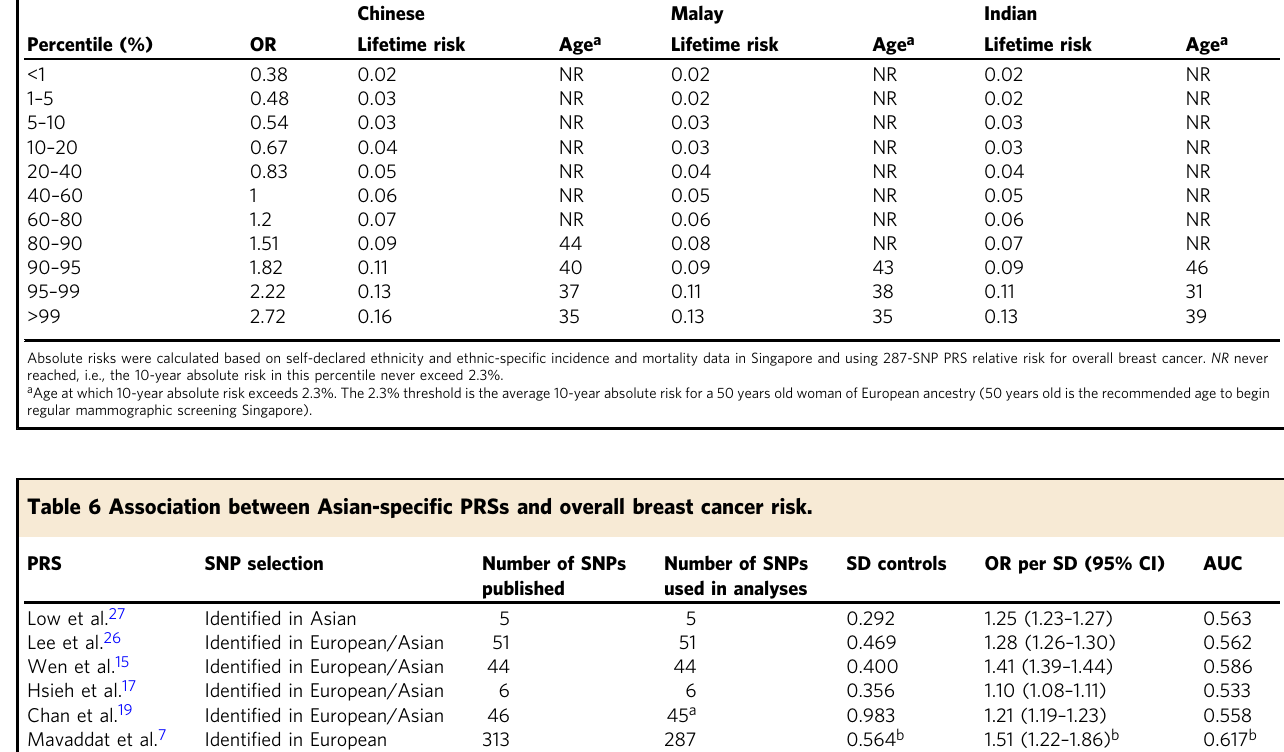
PRSswereconstructedusingperallelelogoddsratiosasreportedintheliterature.AsAsiancase – controlstudiesgenotypedbyiCOGsarrayand744samplesfromMYBRCAbatch1wereusedaspartof the development studies in Wen et al. (2016), to avoid upward bias, we restricted these evaluation analyses to Asian cases – controls studies genotyped using the OncoArray and removed overlapping samples in MYBRCA batch 1.